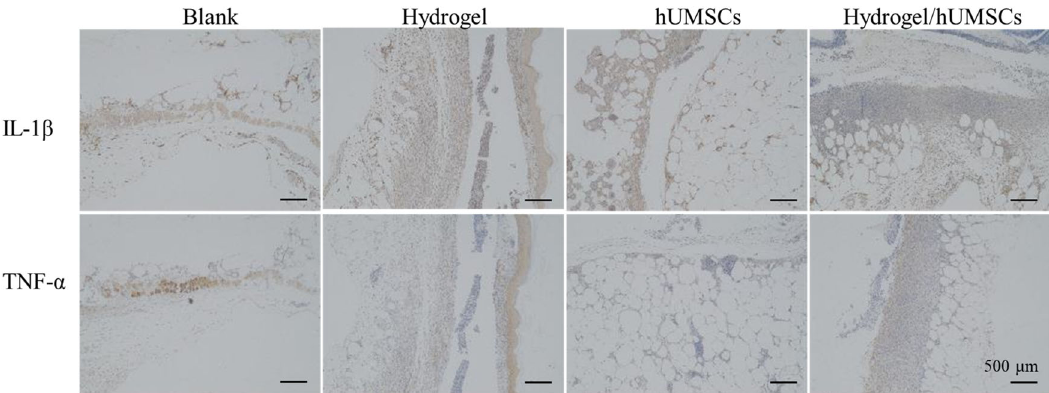
Fig. 6 Immune factors expression of wounds for day 7. Expression of TNF- α at the wound sites of rats in the control, the hydrogel and hUMSCs alone or combined group at 7 days after the operation, as revealed by IHC. The bar corresponds to 500 μ m